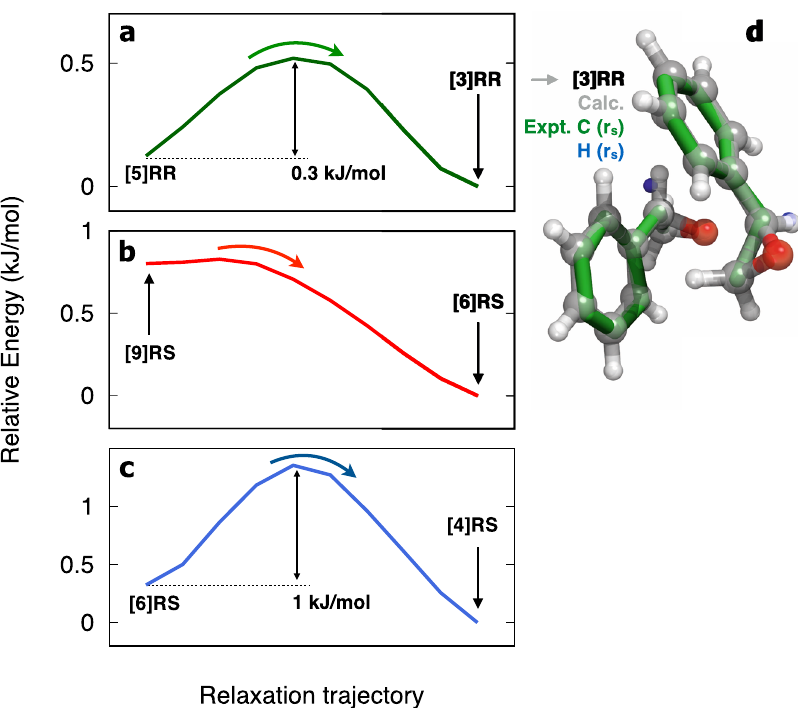
Fig. 4 Relaxation trajectories connecting the local minima of the relevant SO dimers. The calculated pathways were computed using the Nudged Elastic Band method at the B3LYP/def2-TZVP level of theory as implemented in ORCA. a Trajectory [5]RR → [3]RR, b trajectory [9]RS → [6]RS, c trajectory [6] RS → [4]RS and d overlay of experimental (r s ) and calculated geometries of the [3]RR